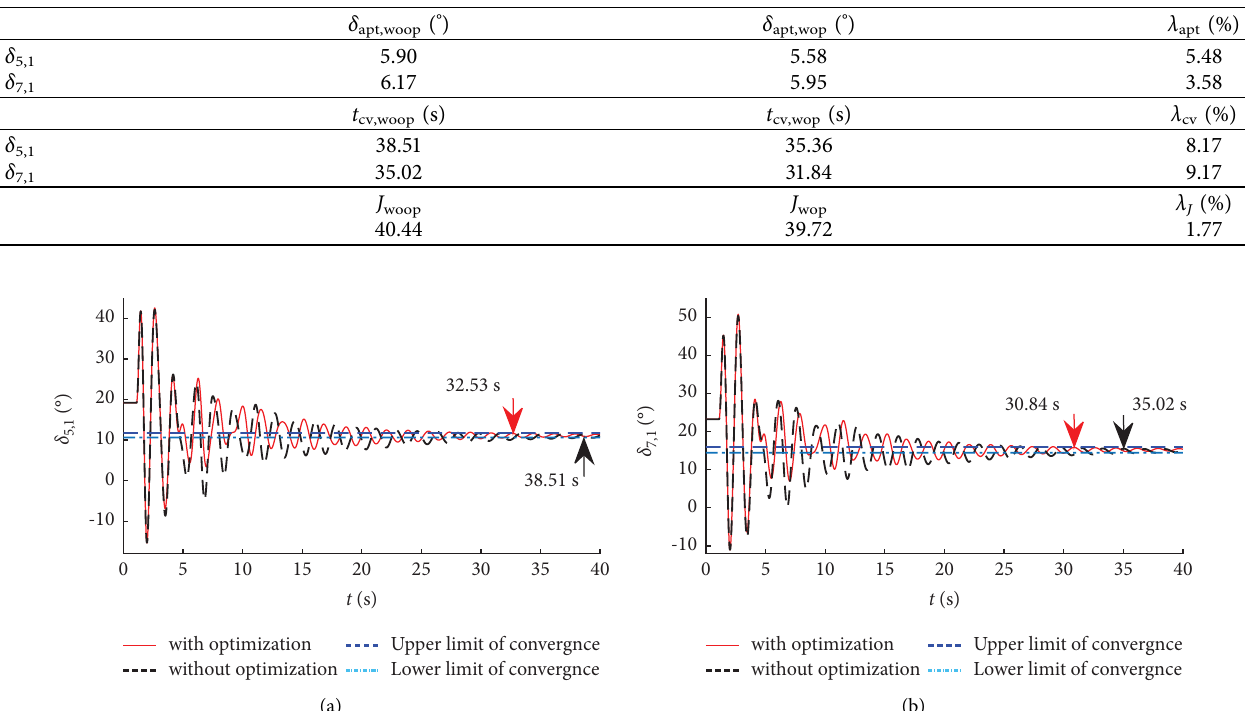
Figure 11: Power angle diference between SGs with and without optimization to K A , K F , and T F . (a) Power angle diference between #5 and #1 SGs. (b) Te power angle diference between #7 and #1 SGs. Table 8: Efect analysis of optimization for K A , K F , and T F .